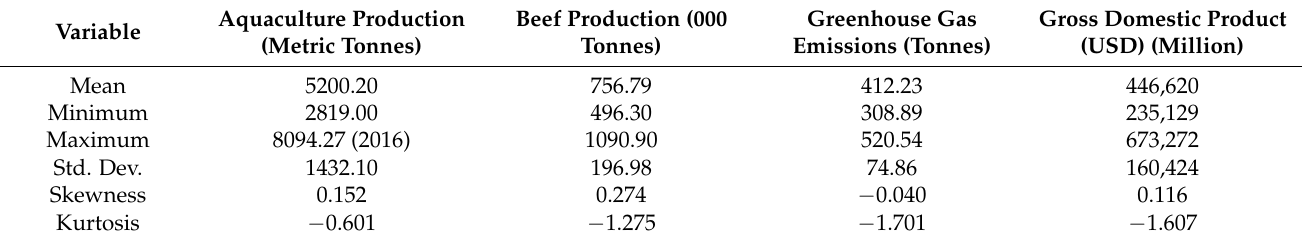
Table 1. Descriptive statistics.